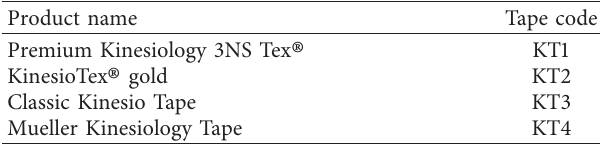
Figure 1: Injured area before and after applying Kinesio tape. Table 1: The different Kinesio brands used for the